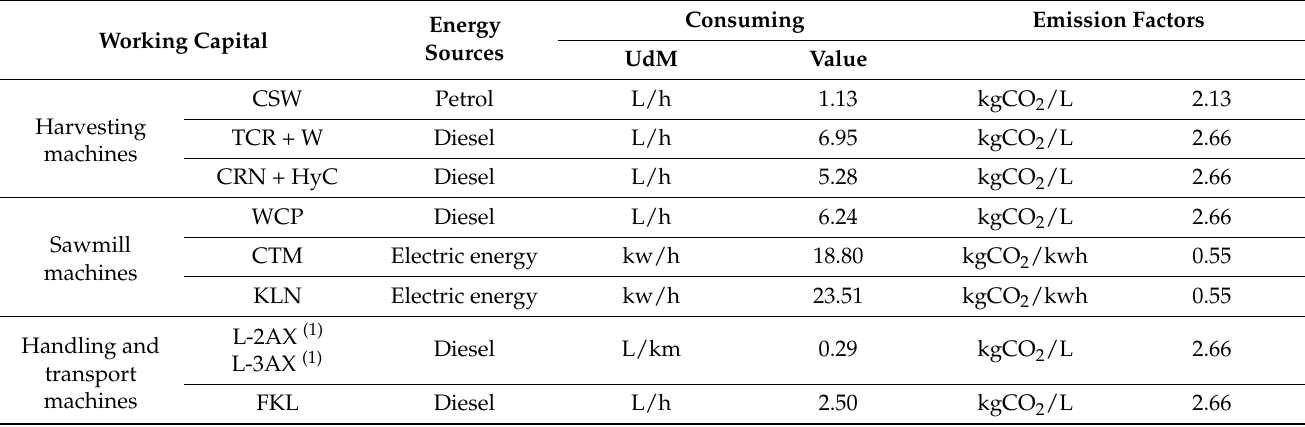
Table 4. Machines used in in the supply chain of chestnut wood to the timber products